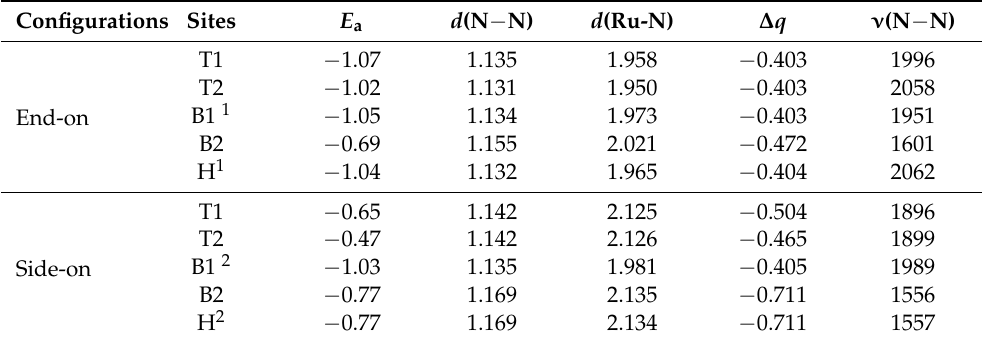
Table 2. Adsorption energy E a (eV), bond length d (Å), vibrational wavenumbers ν (cm − 1 ) and